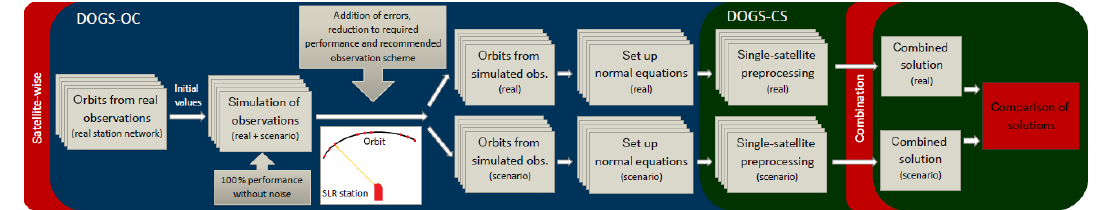
Figure 2. Processing chain of the data simulation and solution calculation with DOGS (DGFI Orbit and Geodetic Parameter Estimation Software) -OC (Orbit Computation library) and -CS (Combination and Solution